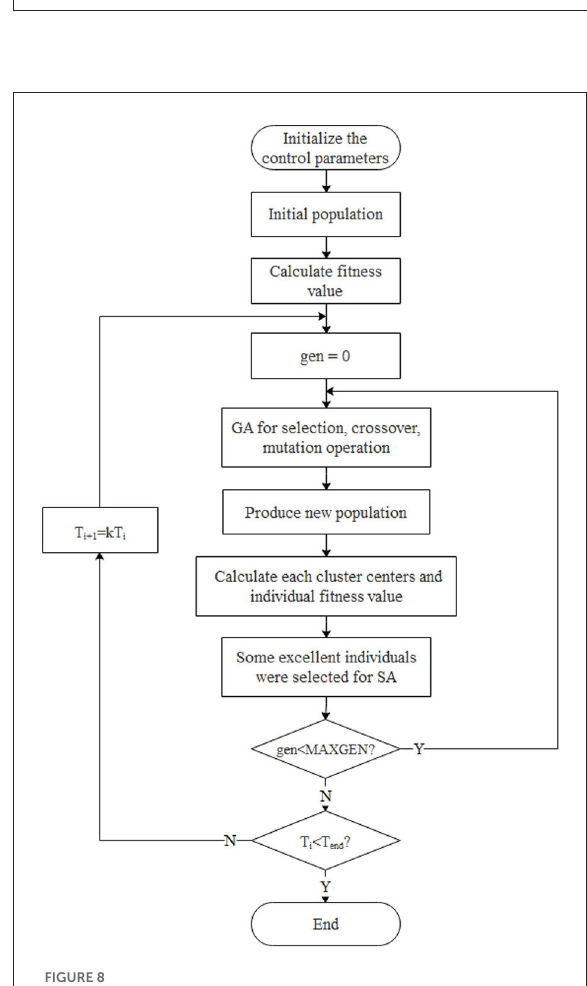
FIGURE8 A schematic representation of the improved AEA algorithm.